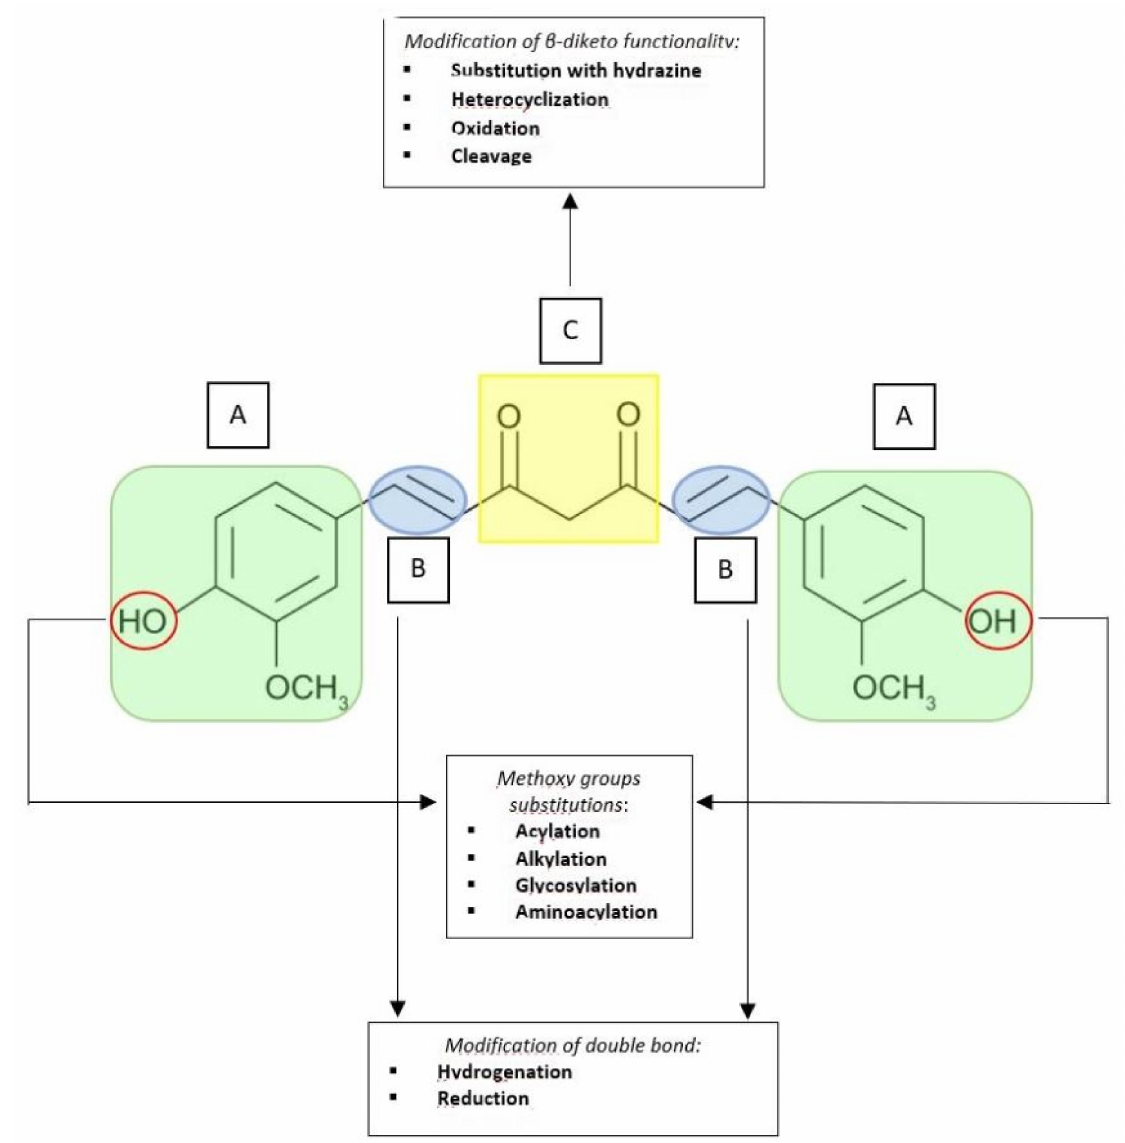
Figure 2. General chemical structure of curcumin derivatives. Curcumin chemical structure include two aromatic rings ( A ) linked to a β -dichetonic group ( C ) through a double bond ( B